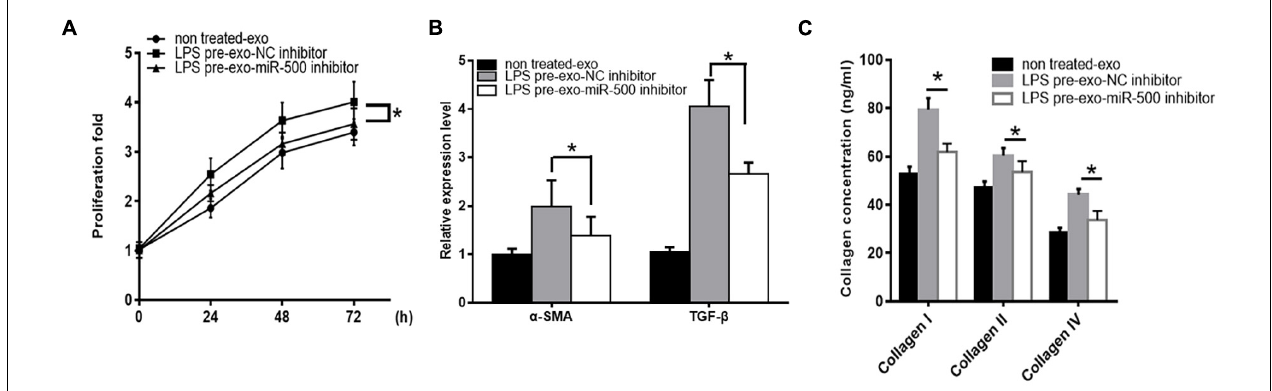
FIGURE 3 | miR-500 inhibition suppresses LPS pre-exo-induced HSC proliferation and activation. (A) HSCs were treated with exosomes derived from LPS-treated macrophages with miR-500 inhibition or not, and then cell proliferation was detected by using CCK-8 assays. (B) HSCs were treated with exosomes derived from LPS-treated macrophages with miR-500 inhibition or not, and the expression levels of α -SMA and TGF- β were detected by qRT-PCR. (C) HSCs were treated with exosomes derived from LPS-treated macrophages with miR-500 inhibition or not, and the concentrations of type I, III, and IV collagen in the cell culture supernatant were tested by ELISA. The results are mean ± SD of three independent experiments. * P <